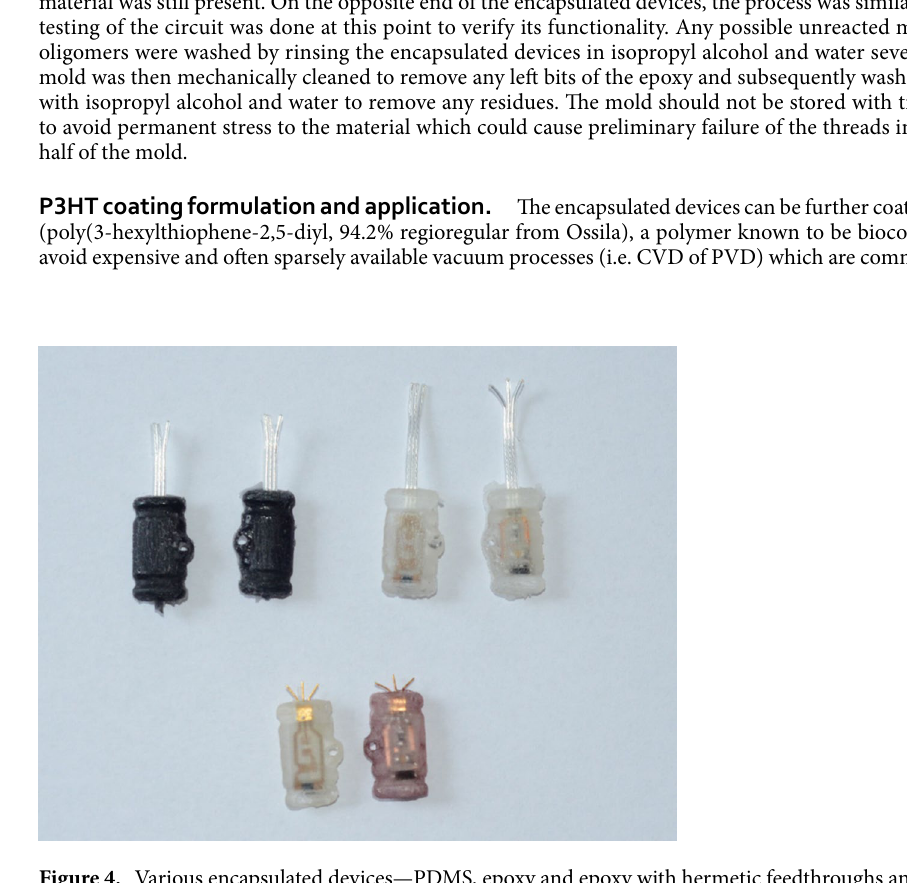
Figure 4. Various encapsulated devices—PDMS, epoxy and epoxy with hermetic feedthroughs and optional P3HT